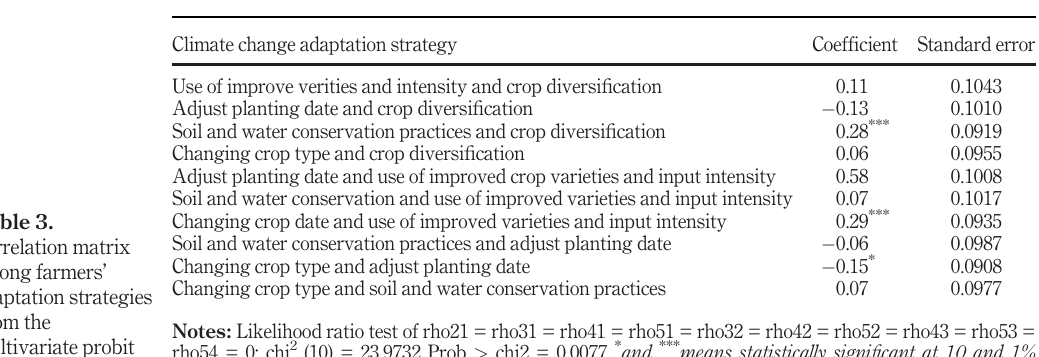
Table 2. Major adaptation strategies used by farmers in the Central part of Ethiopia